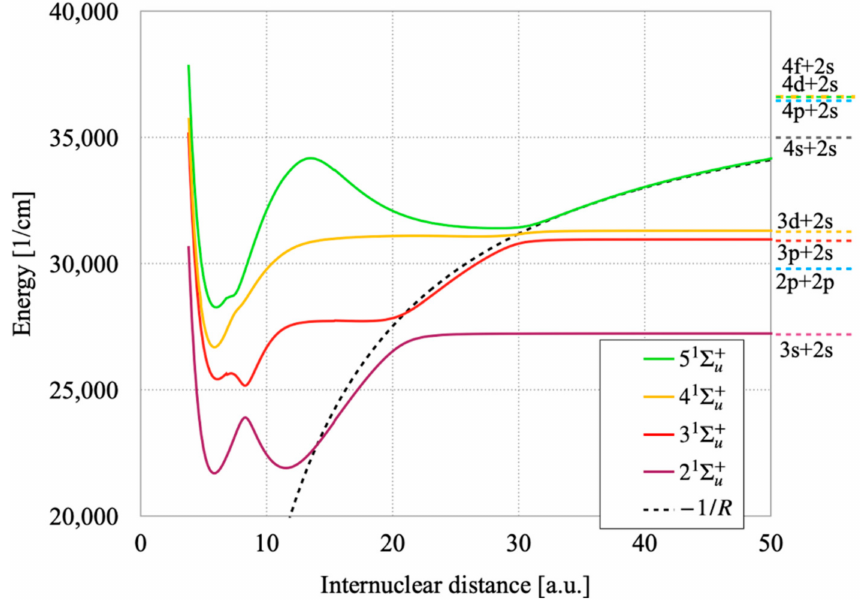
Figure 1. Potential energy curves of the 2, 3, 4 and 5 1 Σ u+ states of 7 Li 2 . In the case of the third state (3 1 Σ u+ ), three kinds of bonds, (3s + 2s), (3p + 2s) and (3d + 2s), interfere to make a very strange PEC with double well. An avoided